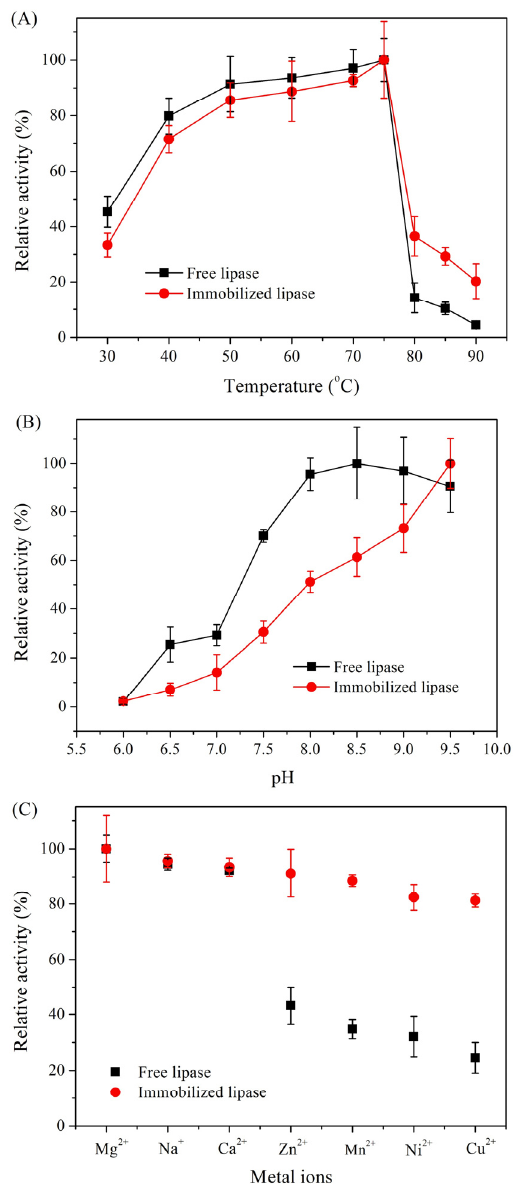
Figure 6. Effects of temperature ( A ), pH ( B ), and metal ions (1 mM) ( C ) on the hydrolytic activity of free lipase QLM ( blank ) and immobilized enzyme ( red ).